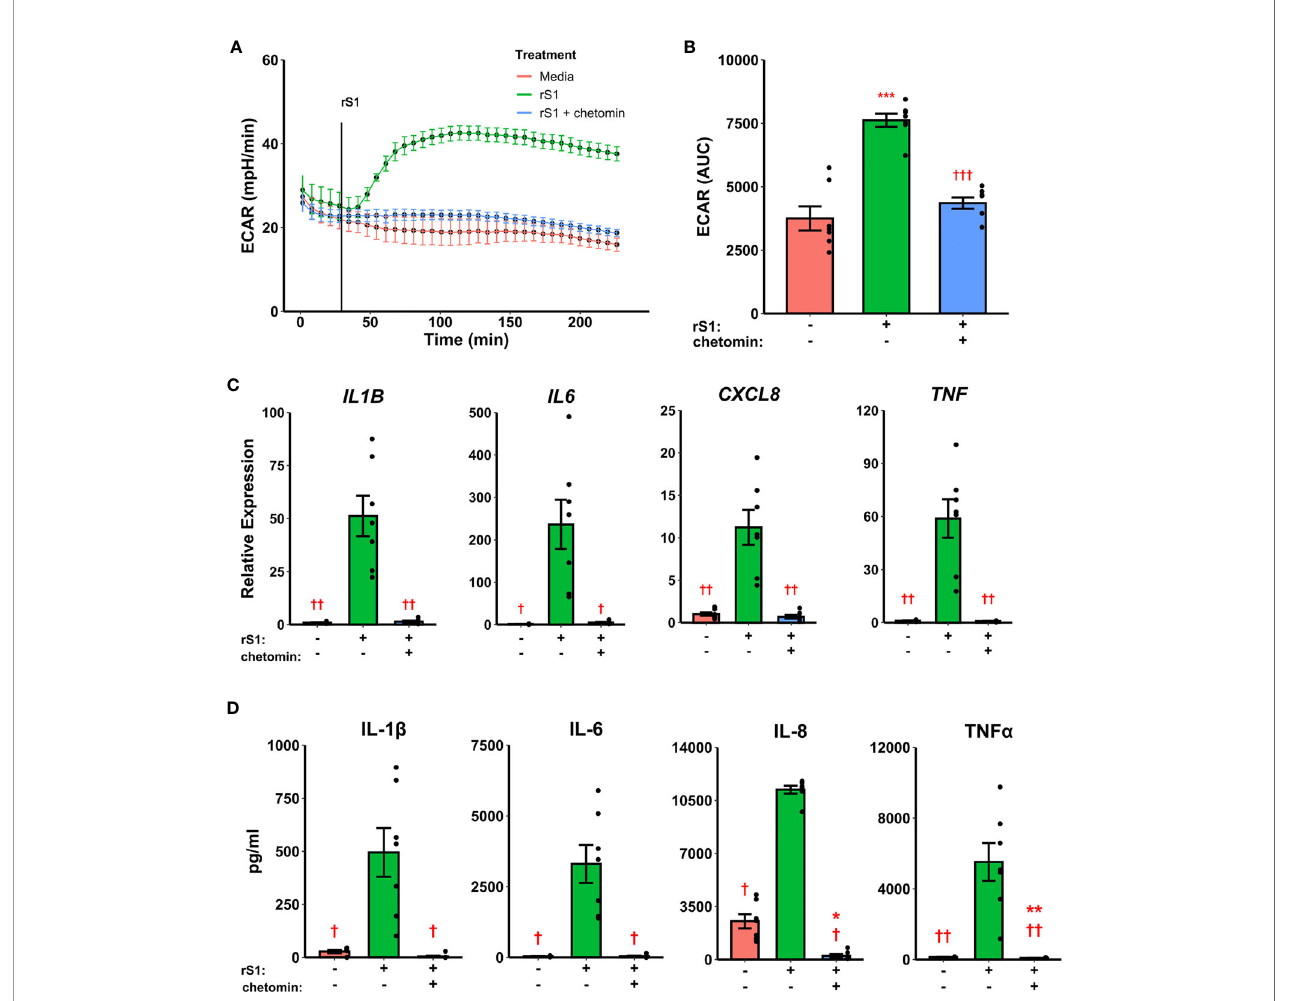
FIGURE 3 | HIF-1 a inhibition suppresses immunometabolic activation of monocytes due to recombinant spike protein (rS1). (A) Monocytes increase extracellular acidi fi cation response rate (ECAR) when treated with 30 nM rS1, but this is blocked by pre-treatment with chetomin. (B) Quanti fi cation of ECAR by area under the curve (AUC). (C) rS1 increase of expression of IL1B , IL6 , CXCL8 , and TNF is reversed by chetomin pre-treatment. (D) rS1 increase of IL-1 b , IL-6, IL-8, and TNF a is reversed by chetomin pre-treatment. *, **, ***: p < 0.05, p < 0.01, p < 0.001 vs . untreated cells. † , †† , ††† : p < 0.05, p < 0.01, p < 0.001 vs . rS1-treated cells. N = 7 biological replicates. Bars and error bars are mean ±